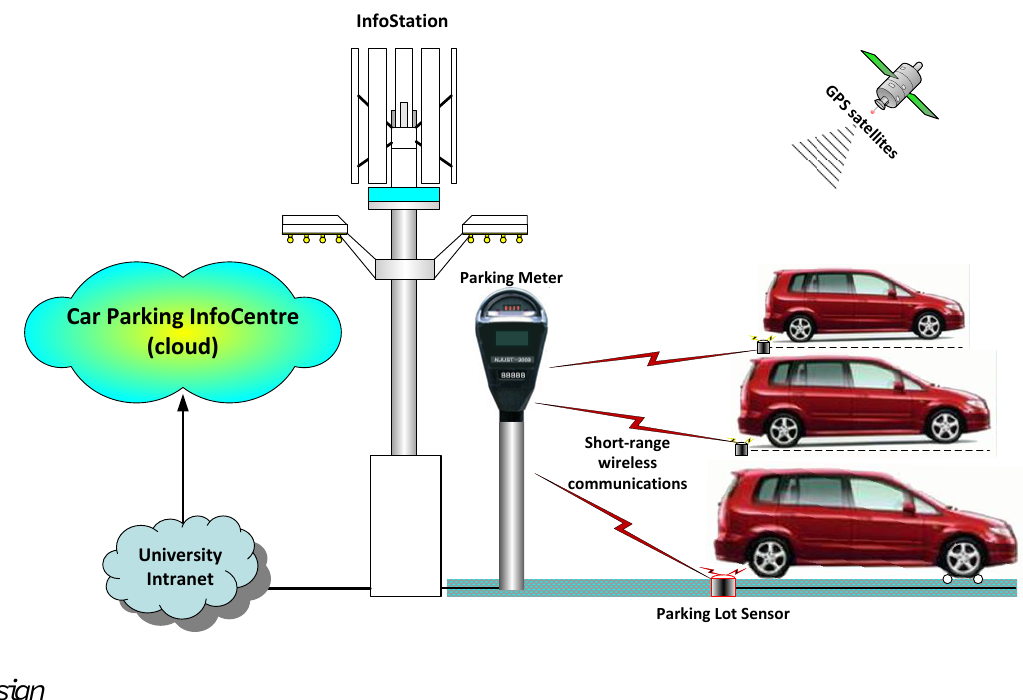
Figure 6. An infoStation-based university car parking